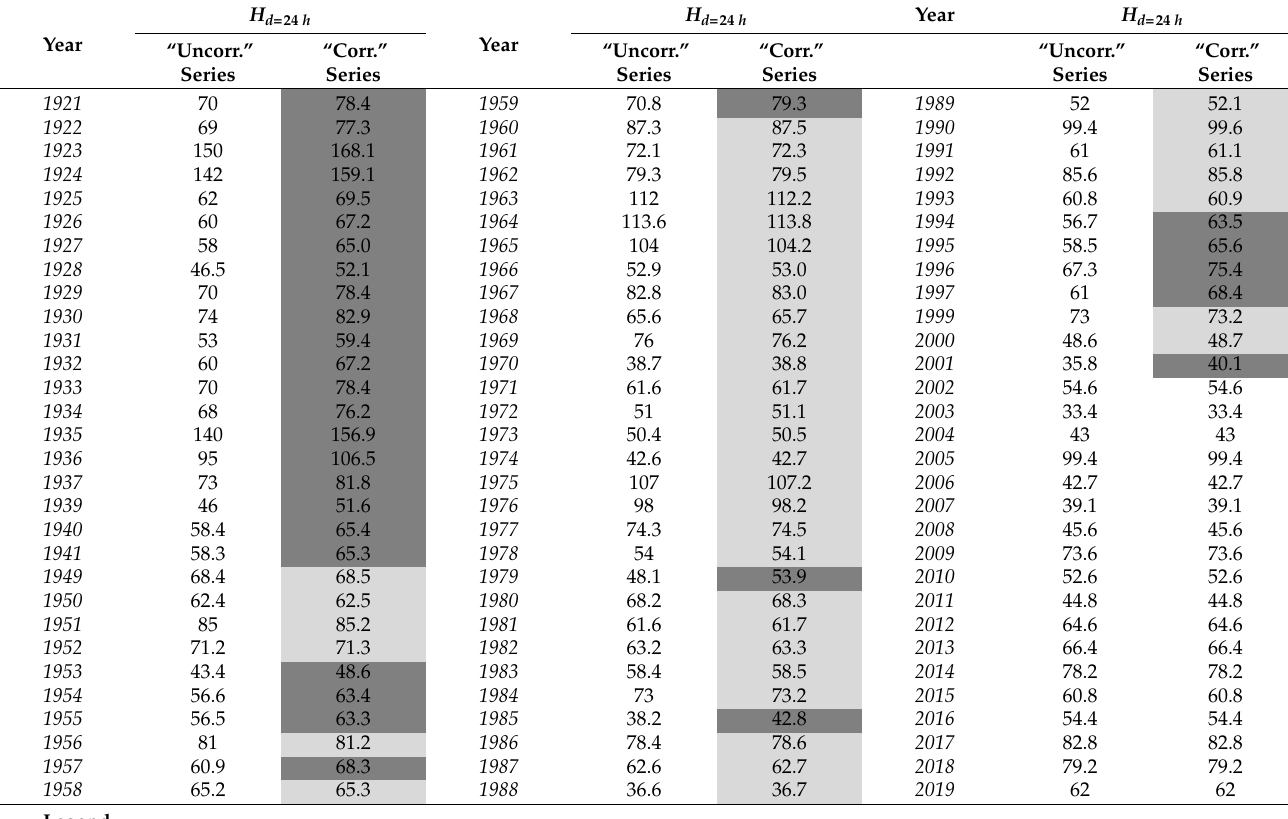
Table 4. Annual maximum rainfall depths (in mm) for duration ( d ) equal to 24 h, H d= 24 h , in the original version (“uncorr.”) and in the modified version through Equation (5c) (“corr.”). Spoleto rain gauge station. H d= 24 h Year “Uncorr.”